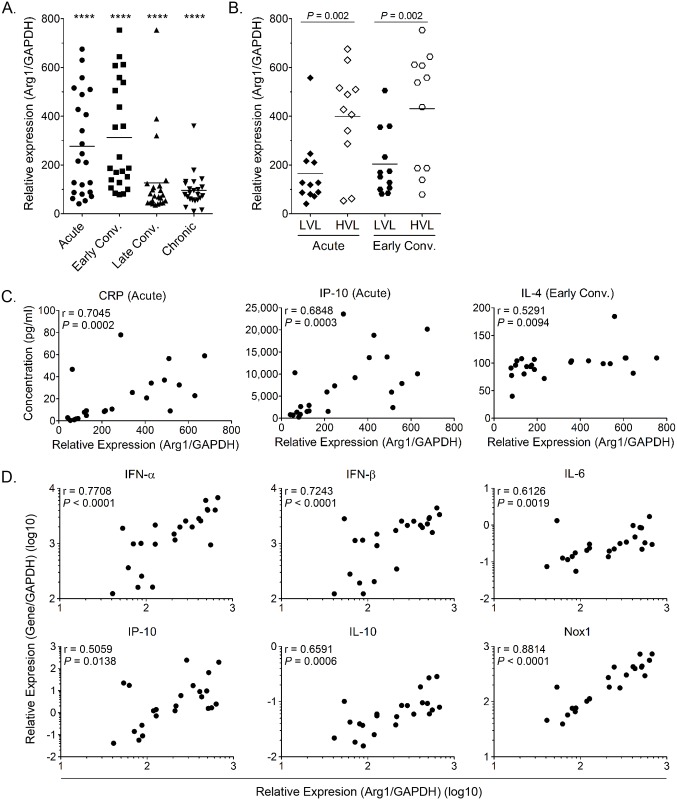
Arg1 is significantly induced in PBMCs collected from CHIKV-infected patients and expression correlates with viral load.(A) PBMCs isolated from CHIKV-infected patients (n = 23) were analyzed for Arg1 gene expression compared to healthy controls (n = 8). At each time point analyzed, Arg1 expression was found to be statistically different from healthy controls (**** P < 0.001), as determined by performing a two-tailed Mann Whitney U test. Each dot represents a patient, and the horizontal line represents the mean. (B) Based on their viremia during the acute and early convalescent phase of infection, patients were grouped into either a low viral load group (LVL; n = 11) or a high viral load group (HVL; n = 12). Arg1 expression was compared between the two groups via two-tailed Mann Whitney U test. * P < 0.05. (C and D) Spearman’s correlation analysis between transcriptional profiles of Arg1 expression in PBMCs of CHIKV-infected patients (n = 23) and (C) acute plasmatic C-reactive protein (CRP) and IP-10 levels, and IL-4 plasma levels during the early convalescent phase as well as (D) IFN-α, IFN-β, IL-6, IP-10, IL-10, and Nox1 genes during acute disease. The level of Arg1 gene expression was expressed relative to healthy controls (n = 8) after normalization to GAPDH. Early Conv., early convalescent phase.